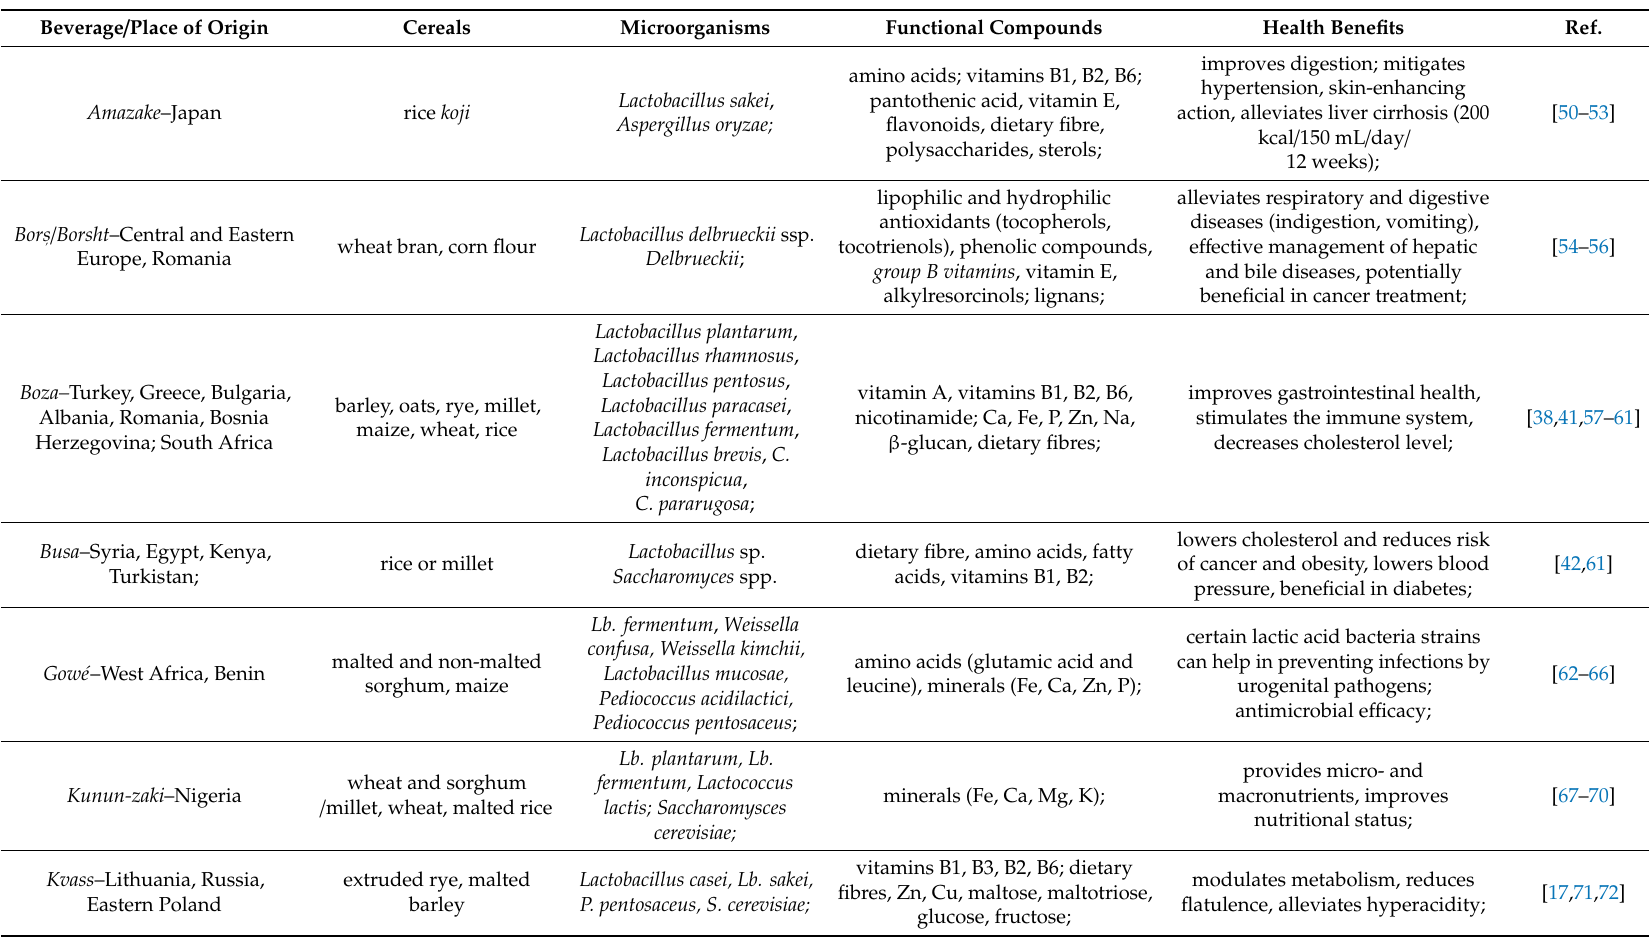
Table 1. Non-alcoholic fermented cereal beverages and their microorganisms, nutritional composition, and health